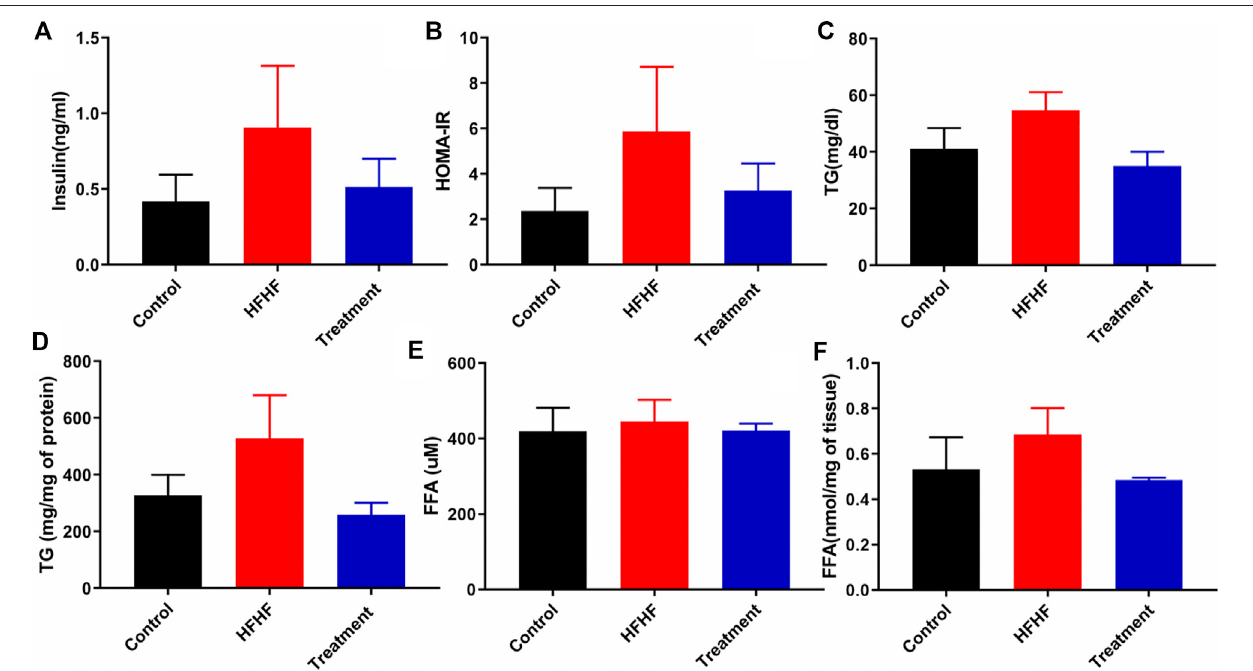
FIGURE 2 | Effect of Lysimachia candida Lindl. extract administration on the serum and liver levels of biochemical parameters of rats (A) Serum insulin, (B) HOMA IR, (C) Serum triglycerides, (D) Livertriglycerides, (E) Serum freefatty acid, (F) Liverfreefatty acid.Dataare expressed asmean ± SD( n (cid:2) 6)each group, comparedwith HFHF group.